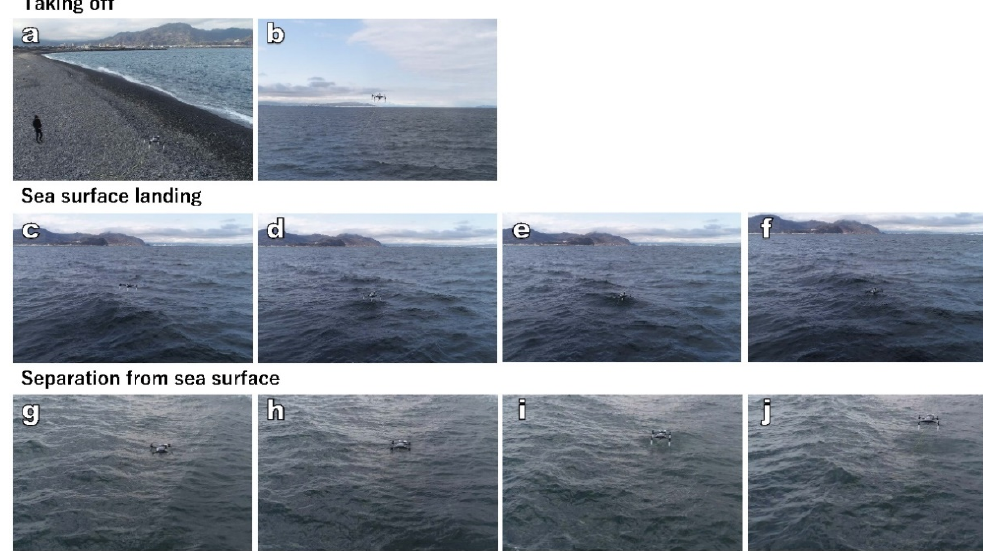
Figure 6. Snapshots of UAV operation as a buoy. (a) UAV takeoff from the base. (b) UAV flying to the observation point. (c–f) Snapshots of UAV landing. (g–j) Snapshots of UAV lifting off.